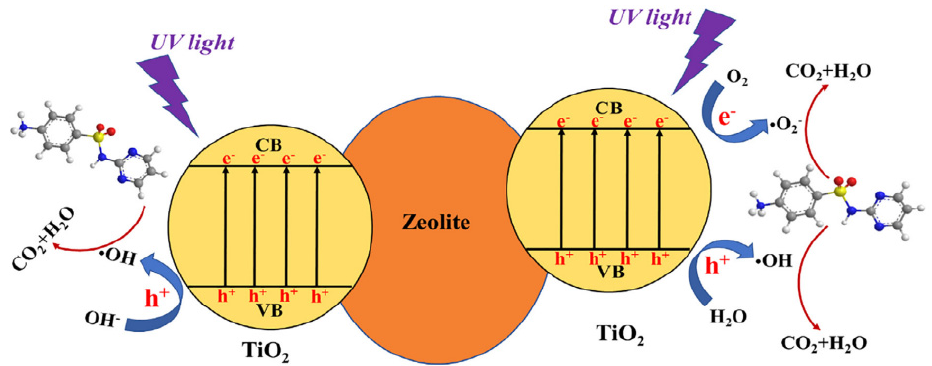
Figure 16. Mechanism of sulphadiazine removal by using zeolite/TiO2 composite. Reprinted with permission from Ref. [23]. Copyright 2018 Elsevier.